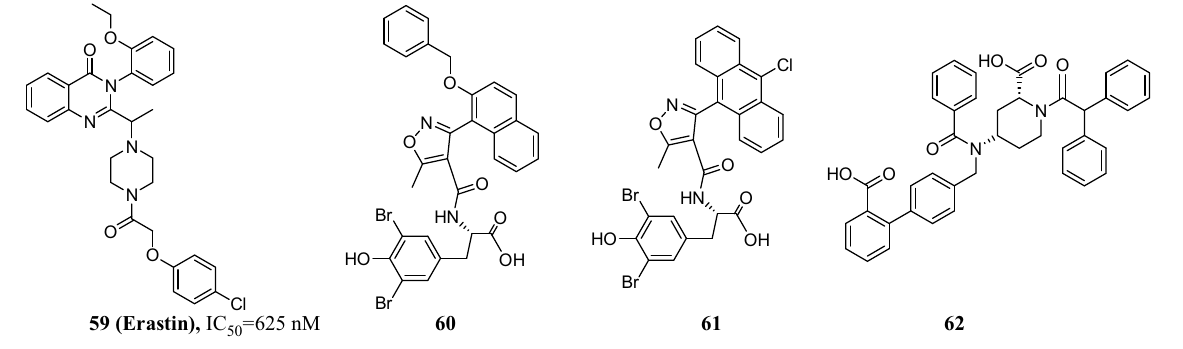
Figure 19: Chemical structures of compounds 59 – 62.